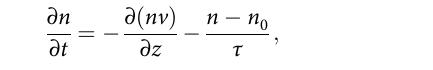
dip . c Resulting distribution of the